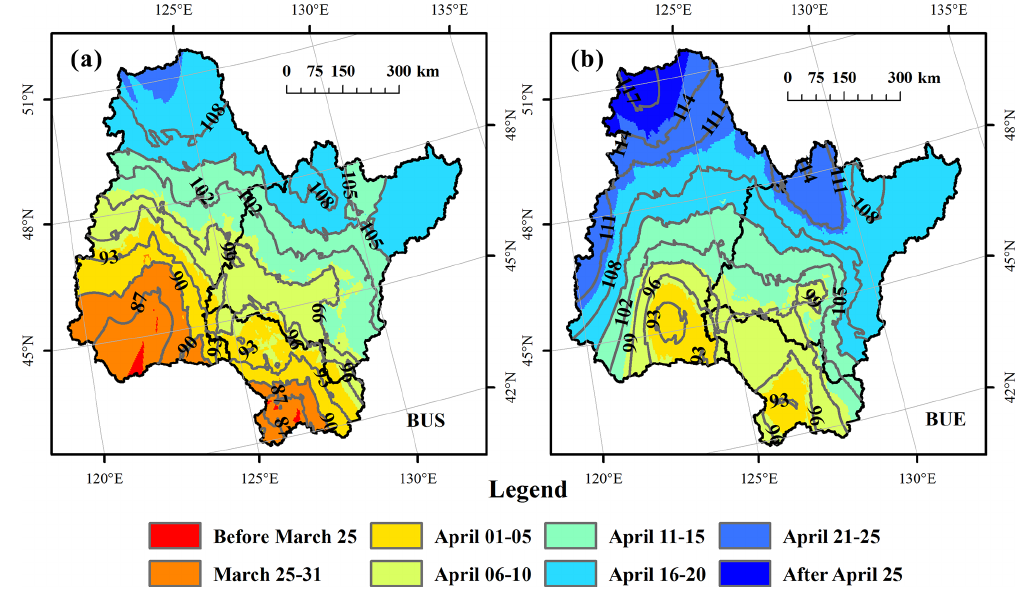
Figure 3. The average spatial distribution of break-up start (BUS) (a) and break-up end (BUE) (b) in the Songhua River Basin of northeast China from 2010 to 2015. The number labels indicate the day of year (DOY) of the